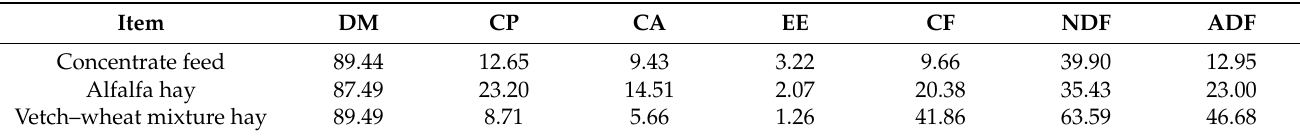
Table 1. Chemical composition of concentrate and roughages 1